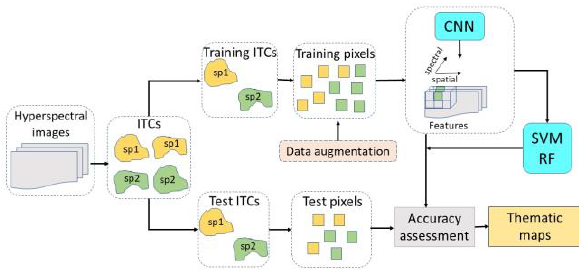
Figure 3. Methodological flowchart of tree species classification using the CNN method and CNN-SVM/ CNN-RF approaches. species; ITC= individual tree